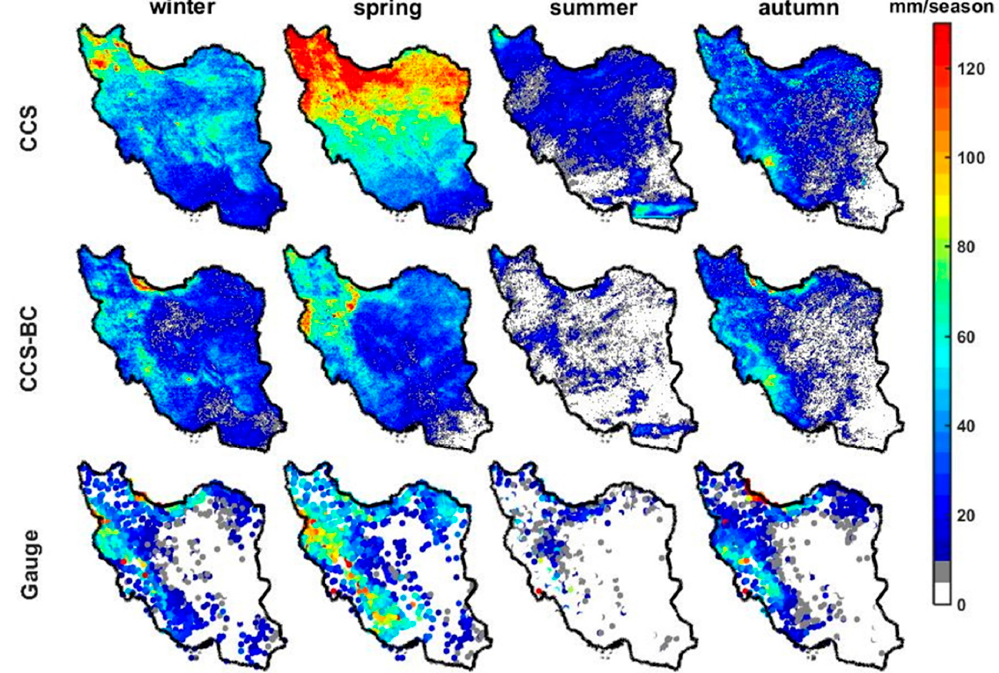
Figure 7. Mean seasonal precipitation from the gauge observations and the CCS and the CCS-BC for the validation period.